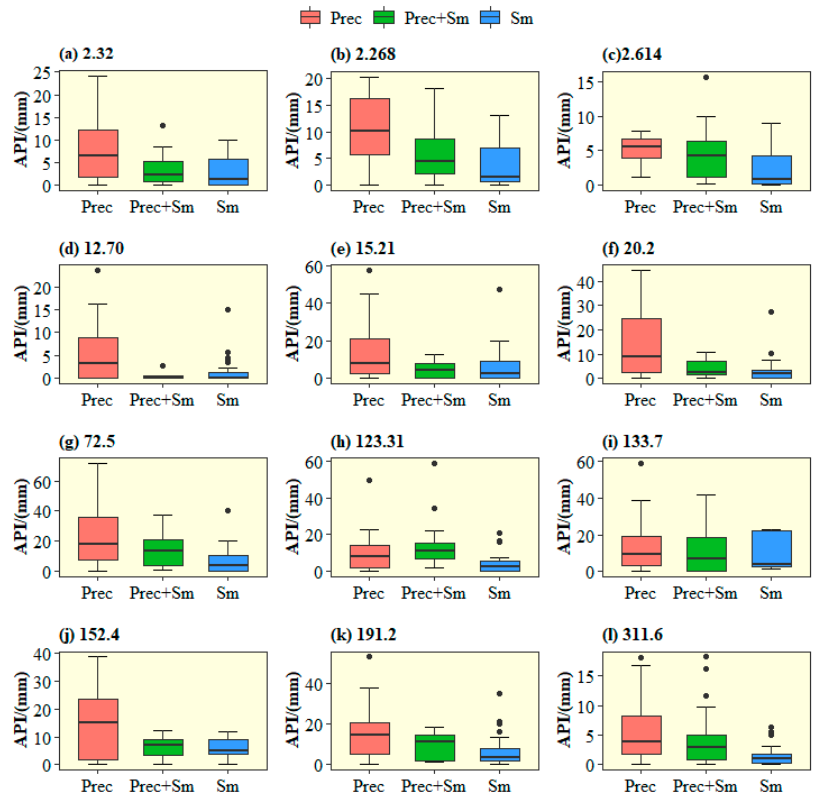
Figure 6. box ‐ plot of the API for different FGMs. The thick black line in the middle of the box is the API median of a certain flood type. The black dots are outliers.